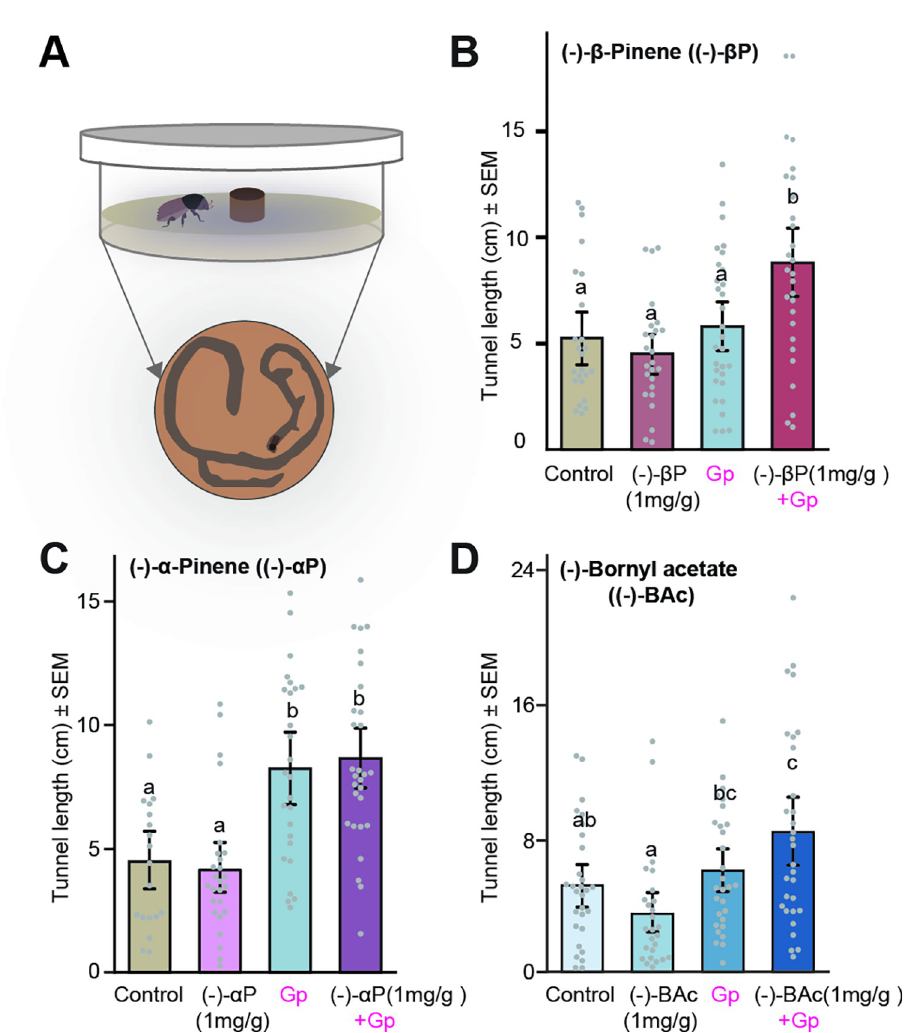
Fig 8. Ips typographus tunnels more in monoterpene-enriched diet in the presence of a symbiotic fungus. (A) Schematic drawing of a Petri dish arena used for the no-choice tunneling assay. The dish was filled with monoterpene- enriched spruce bark agar and inoculated with G . penicillata (Gp) (top). Example of the tunneling pattern of an adult beetle within the fungus-colonized diet as pictured from the bottom side of Petri dish (bottom). (B–D) Tunnel lengths (cm) made by adult beetles after 48 h in diet containing G . penicillata only, monoterpenes only, G . penicillata and monoterpenes, or controls with neither G . penicillata nor monoterpenes. Error bars represent SEM ( n = 30 (15 ♂ , 15 ♀ ) for each trial). Monoterpenes: ( − )- β -pinene (B) , ( − )- α -pinene (C) , ( − )-bornyl acetate (D) . Different lowercase letters indicate significant differences between treatments (ANOVA, Tukey’s test, P < 0.05). The data underlying this Figure can be found at https://doi.org/10.6084/m9.figshare.21692156.v1. mass attacks, the host-derived oxygenated monoterpene cis -verbenol acts together with 2-methyl-3-buten-2-ol as an aggregation pheromone for I . typographus to promote mass attack on individual trees [28,54]. Beetles also utilize oxygenated monoterpenes to restrict the density of attack. Microbes lining the gallery walls or living in the beetle gut oxidize cis- and trans -ver- benol into verbenone, which inhibits the attraction of both sexes to densely colonized trees [55–57]. In addition, mated male I . typographus produce ipsenol and ipsdienol, of which ipse- nol acts as an anti-attractant [57]. Furthermore, an oxygenated monoterpene from host trees, 1,8-cineole, which is produced in higher amounts in resistant or MeJA-primed trees, inhibits